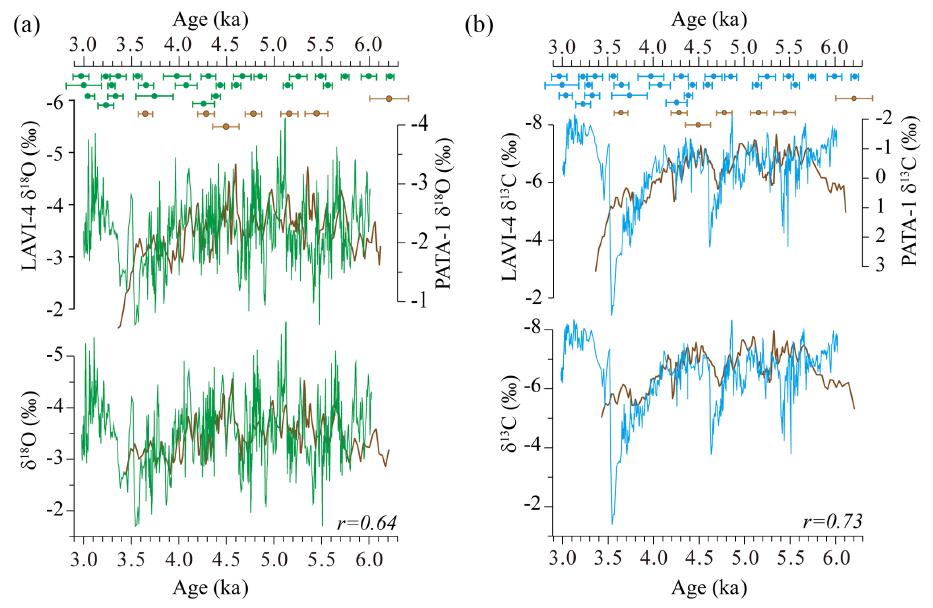
Figure 2. δ 18 O and δ 13 C records of LAVI-4 and PATA-1. (a) δ 18 O profiles of LAVI-4 (green) and PATA-1 (brown) are shown on their independent COPRA age models (top diagram) and ISCAM-derived age models (bottom diagram). The correlation coefficient ( r ) between LAVI-4 and PATA-1 is 0.64 . The PATA-1 δ 18 O values were adjusted by ∼ 1 . 3‰ to match the LAVI-4 data series. (b) Same as in (a) but for the δ 13 C profiles of LAVI-4 and PATA-1. The PATA-1 δ 13 C values were adjusted by ∼ 6 . 5‰ to match the LAVI-4